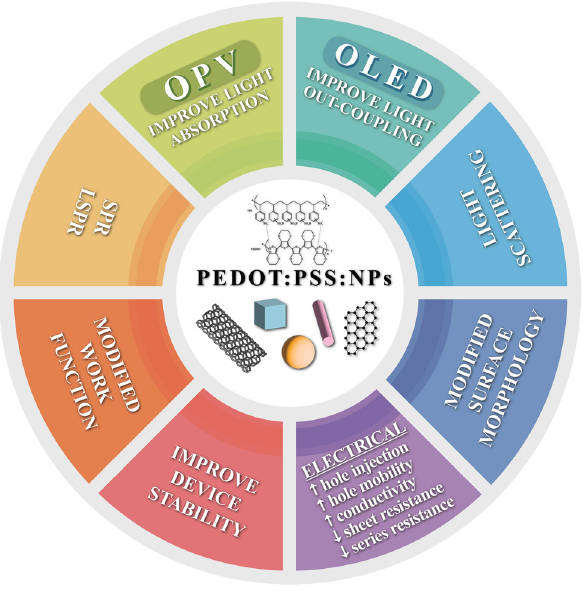
Figure 9: Overview e ff ect of NPs - doped PEDOT:PSS for OLED and OPV.